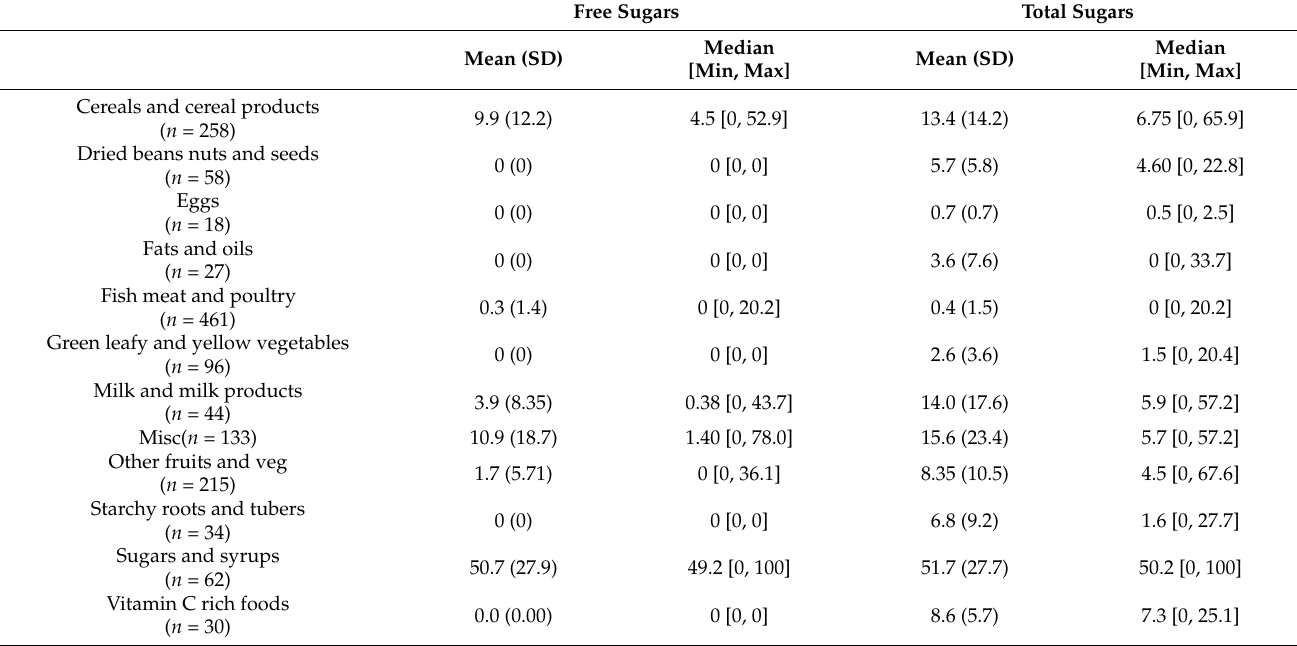
Table 4. Estimated content of free sugars, by food group, in grams per 100 g. The Misc group includes sugar-sweetened beverages, condiments and soups. The Vit C rich foods include citrus fruits, mangos, papayas and tomatoes. Free sugars in the ‘Other fruits and vegetables’ group come mainly from fruit